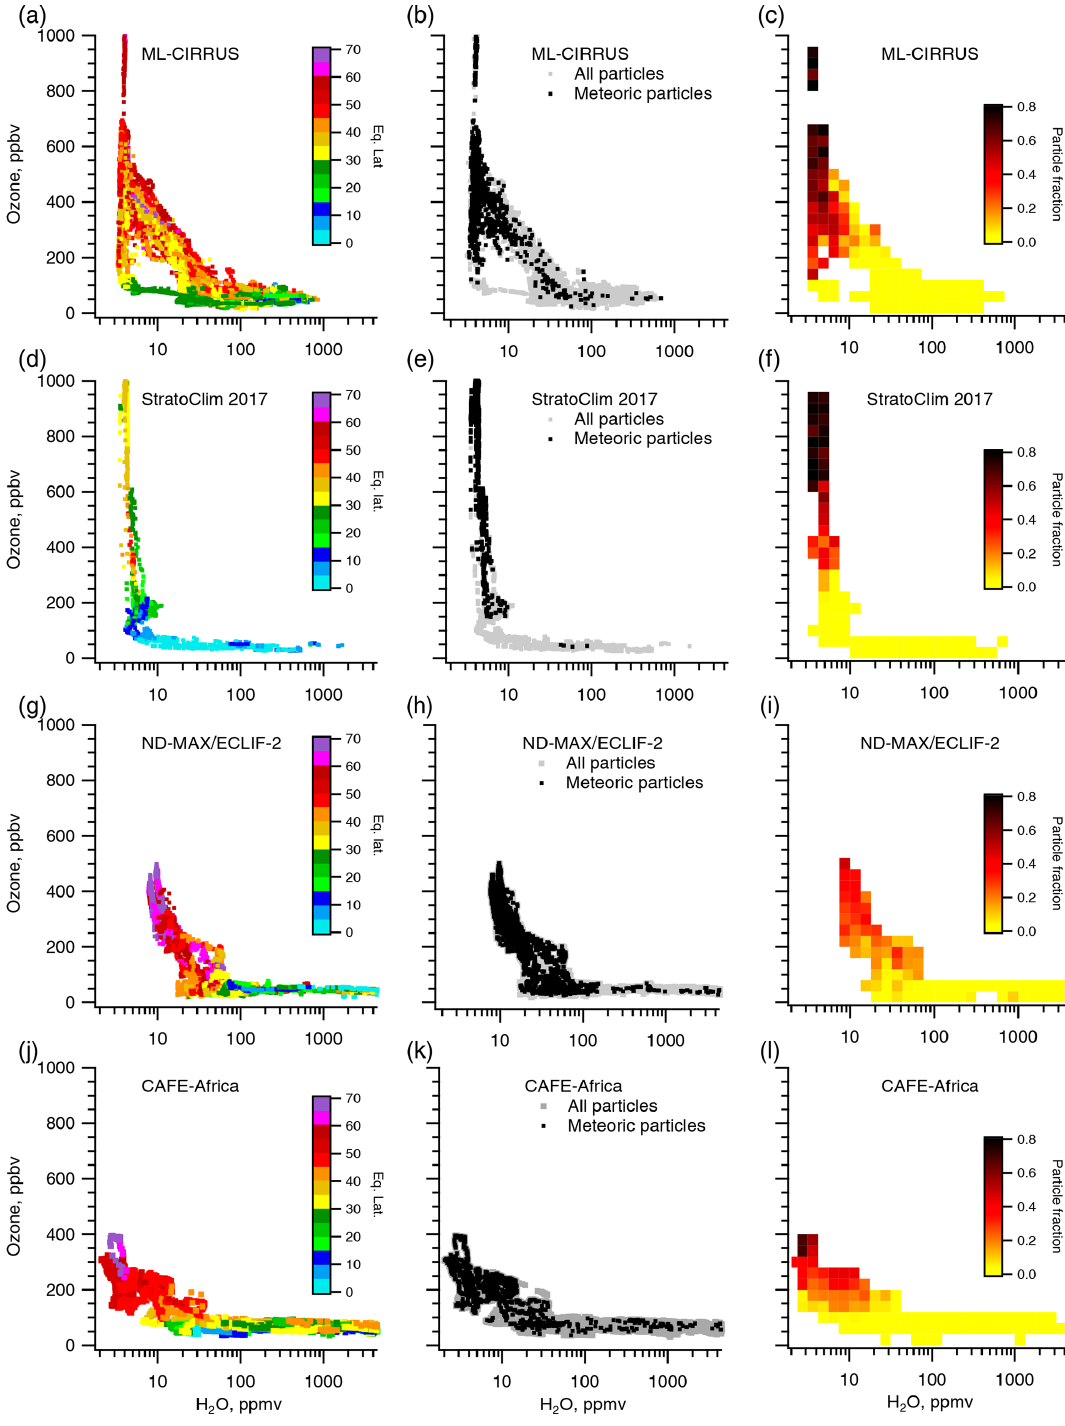
Figure 8. Ozone mixing ratio as stratospheric tracer vs. water vapour mixing ratio as tropospheric tracer colour-coded with equivalent latitude, for ML-CIRRUS (a) , StratoClim 2017 (d) , ND-MAX/ECLIF-2 (g) , and CAFE-Africa (j) . Panels (b) , (e) , (h) , and (k) show O 3 and H 2 O for the times when particle mass spectra were recorded (grey for all particles and black for meteoric particles). Panels (c) , (f) , (i) , and (l) show the proportion of meteoric particles within a O 3 -H 2 O